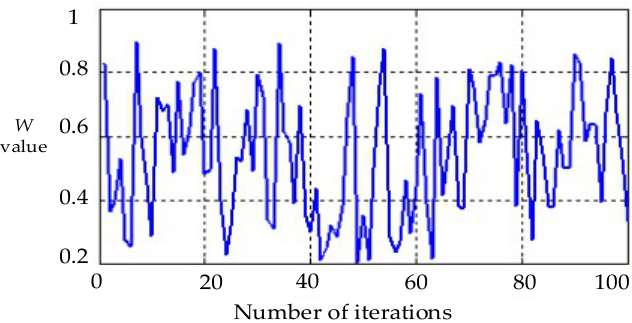
Figure 3. Trend of weight W change combining artificial bee colony (ABC) and particle swarm optimization (PSO).